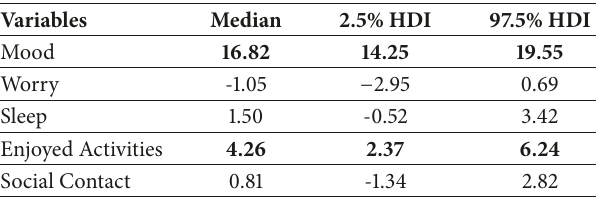
Table 2: Results: estimated model parameters including High Density Interval (significant parameters in bold).